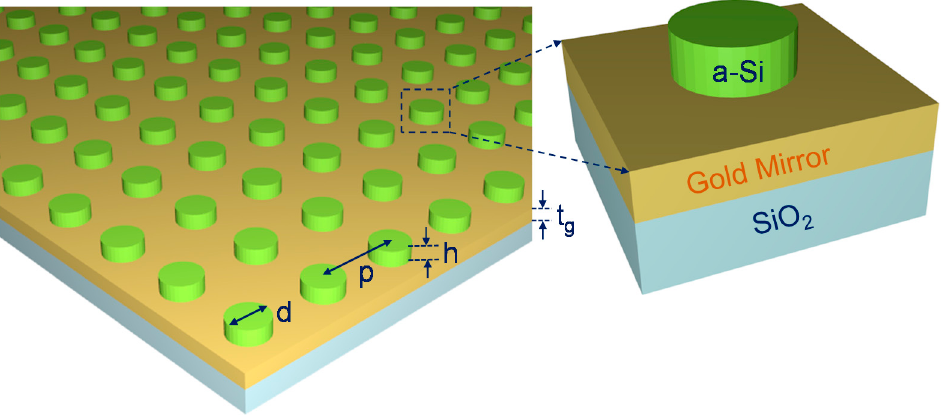
Figure 1. Schematic of the proposed metasurface device (inset shows the unit cell of the metasurface). The a-Si disks are arranged in a symmetric way as a result proposed device will facilitate the polarization insensitive performance which is one of the key requirements for an ideal absorber. We have used the experimental refractive index (RI) value of a-Si which will enhance the performance accuracy in terms of practical realization. The gold film properties are adopted from Johnson and Christy model [33].